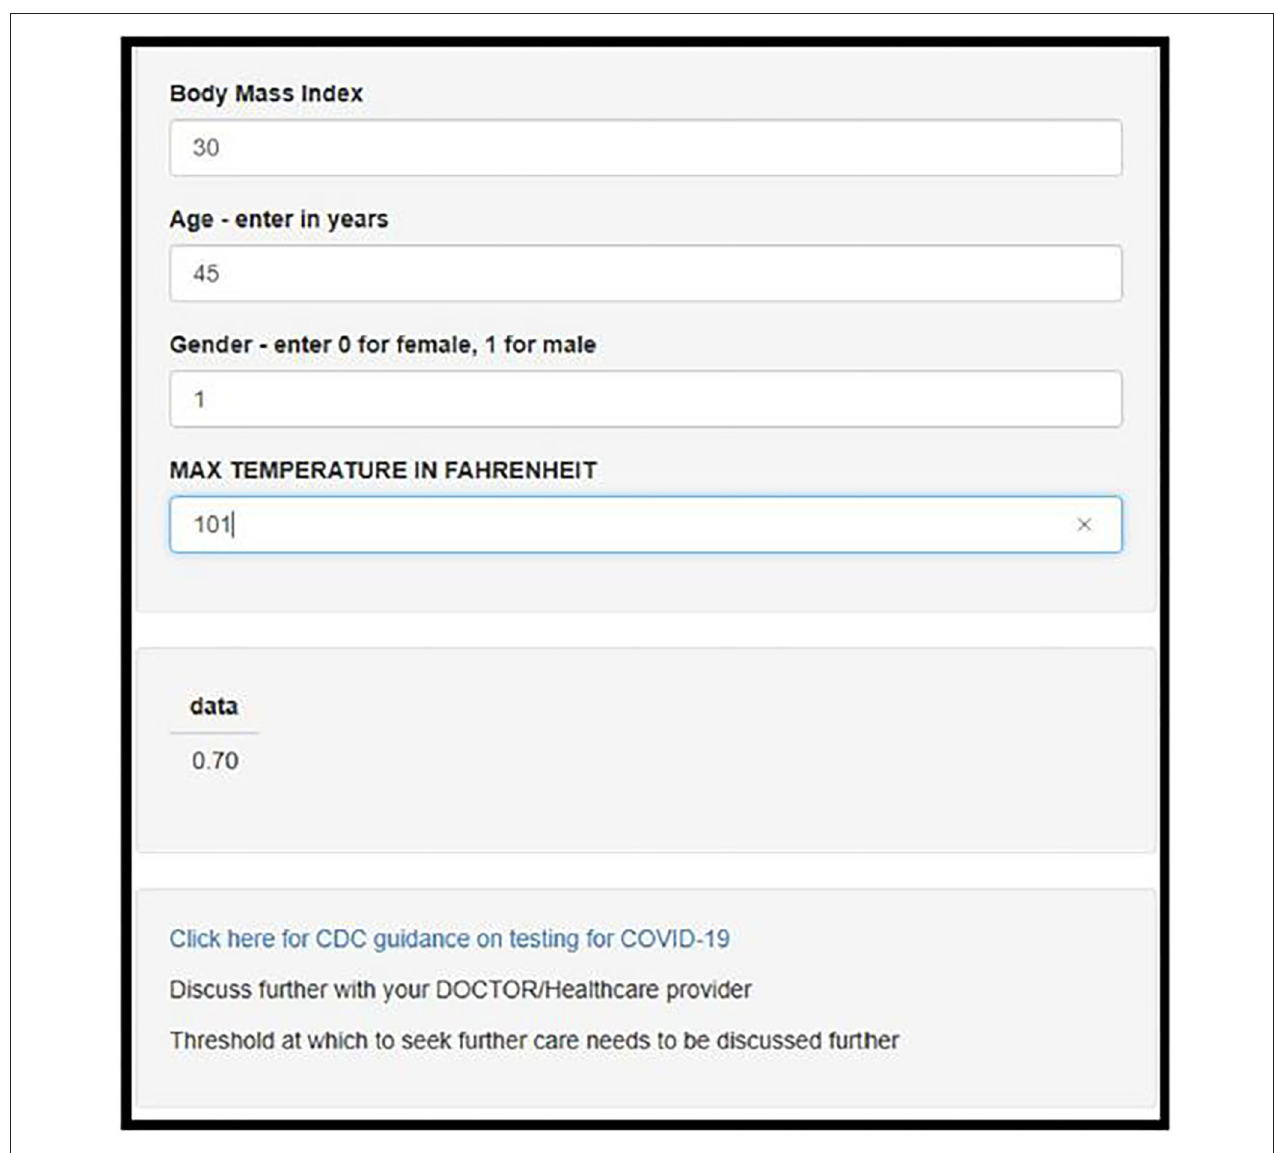
FIGURE 2 | Screenshot of the deployed web-app which is freely available for use online at https://darasriskcalculators.shinyapps.io/Covid_app_x4/.